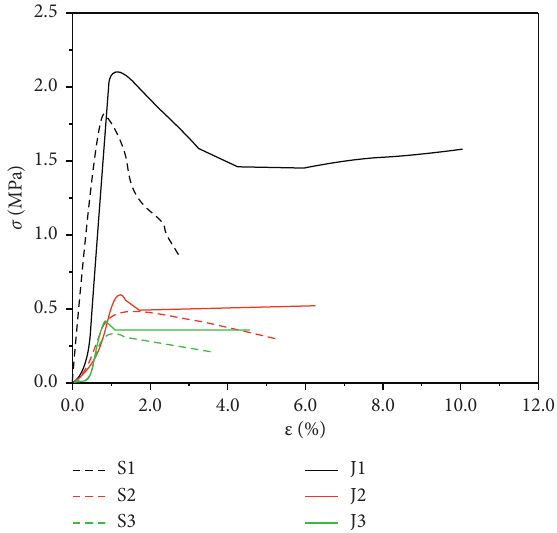
Figure 4: Stress-strain curve of backfill before and after reinforcement. Table 2: Comparison of some mechanical parameters of backfill before and after reinforcement. Without flexible grid-reinforced Ratio